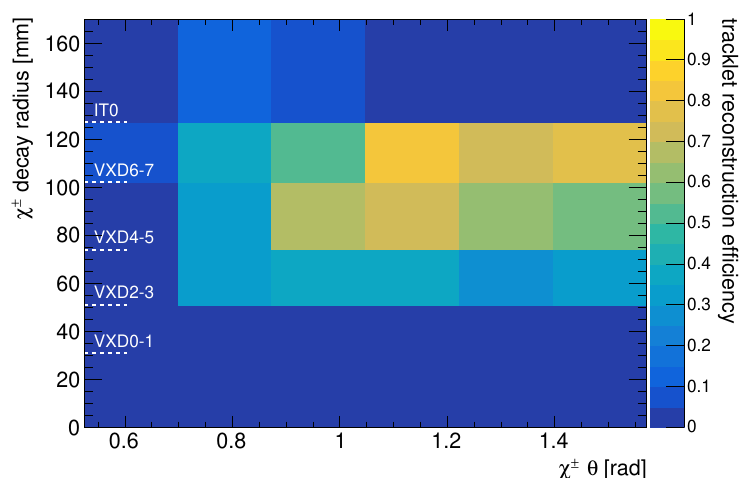
Figure 11. Tracklet reconstruction efficiency as a function of the generator-level ˜ χ ± polar angle θ and radial decay position. The decay radius bin boundaries correspond to the positions of the tracking detector layers in the barrel region, and are highlighted by the white dashed lines and text. The efficiency was found to be symmetric around π/ 2 within statistical uncertainties. The recon- struction efficiency decreases sharply at π/ 6 since hits at smaller polar angles are not considered in the reconstruction, as discussed in section